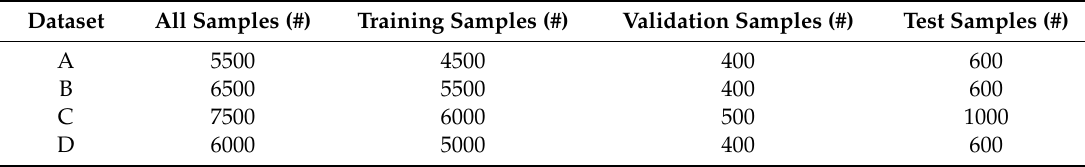
Table 2. The numbers of di ff erent types of samples in four